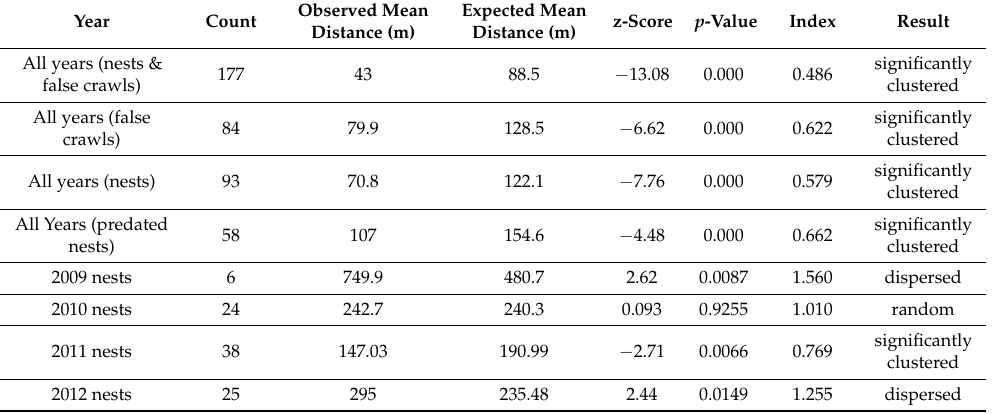
Figure 5. Results from the local Moran’s I cluster analysis using distance to the nearest five predated sea turtle nests: ( A ) 2009, ( B ) 2010, ( C ) 2011, and ( D ) 2012. Table 2. Results from the Average Nearest Neighbor Analysis for sea turtle nests and false crawls.